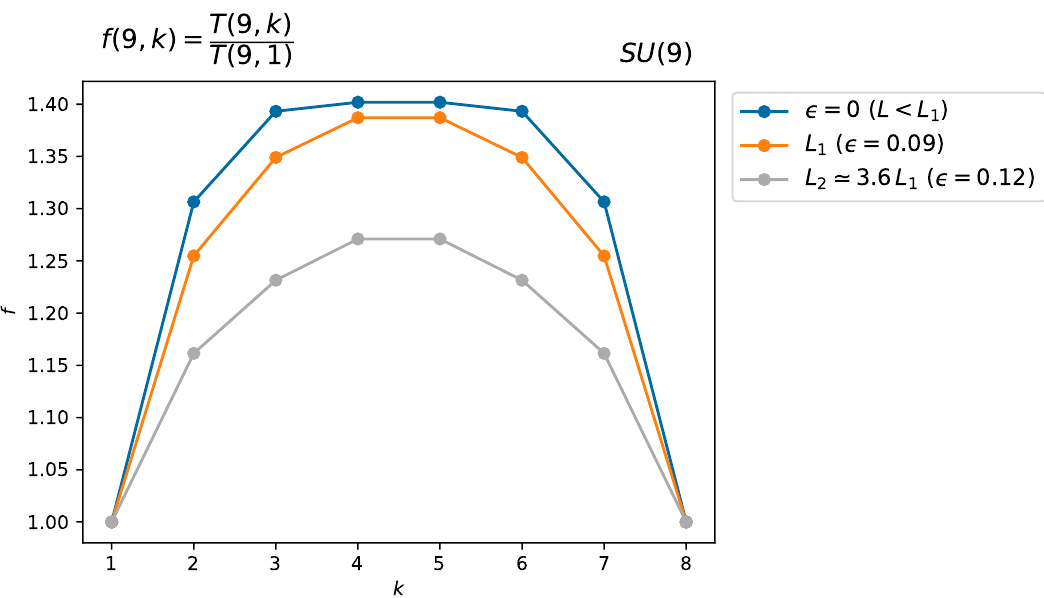
Figure 15. The k -string tension ratio for SU(9) , as a function of L at fixed Λ , for three different values of L , increasing from the top curve towards the bottom one. Clearly, as L increases, the k -string ratios are seen to decrease. Qualitatively, however, the curve near its maximum is not as flat as for (cid:15) = 0 . This effect is entirely due to W -boson (and superpartner) loops. The values of the semiclassical expansion parameters corresponding to the chosen (cid:15) are discussed after eq.